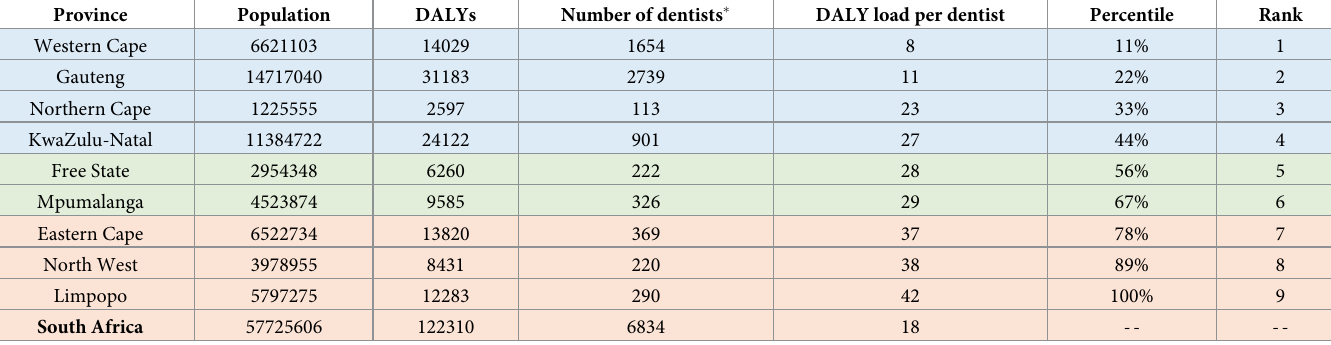
Table 3. Province wide—DALYs, number of dentists (including specialists) and DALY load per dentists in